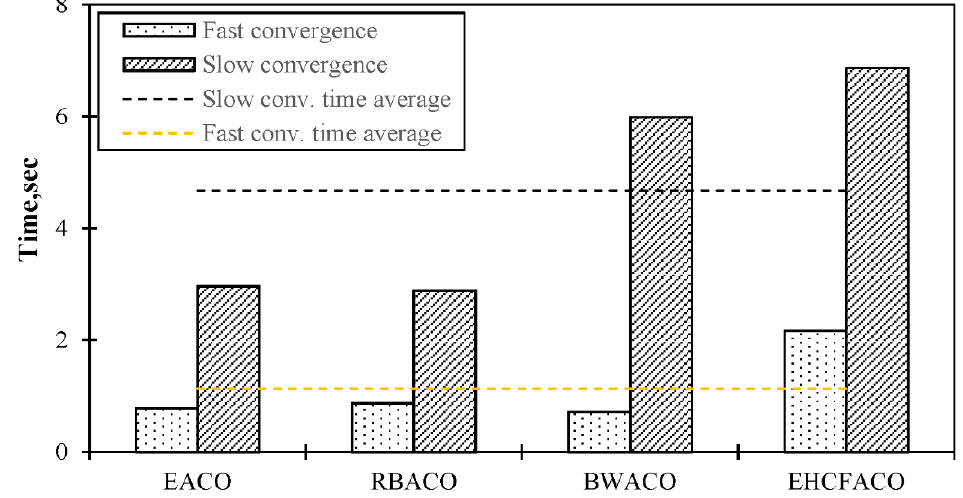
Figure 11. Elapsed time of EACO, RBACO, BWACO, and EHCFACO algorithms to find the optimal solution.